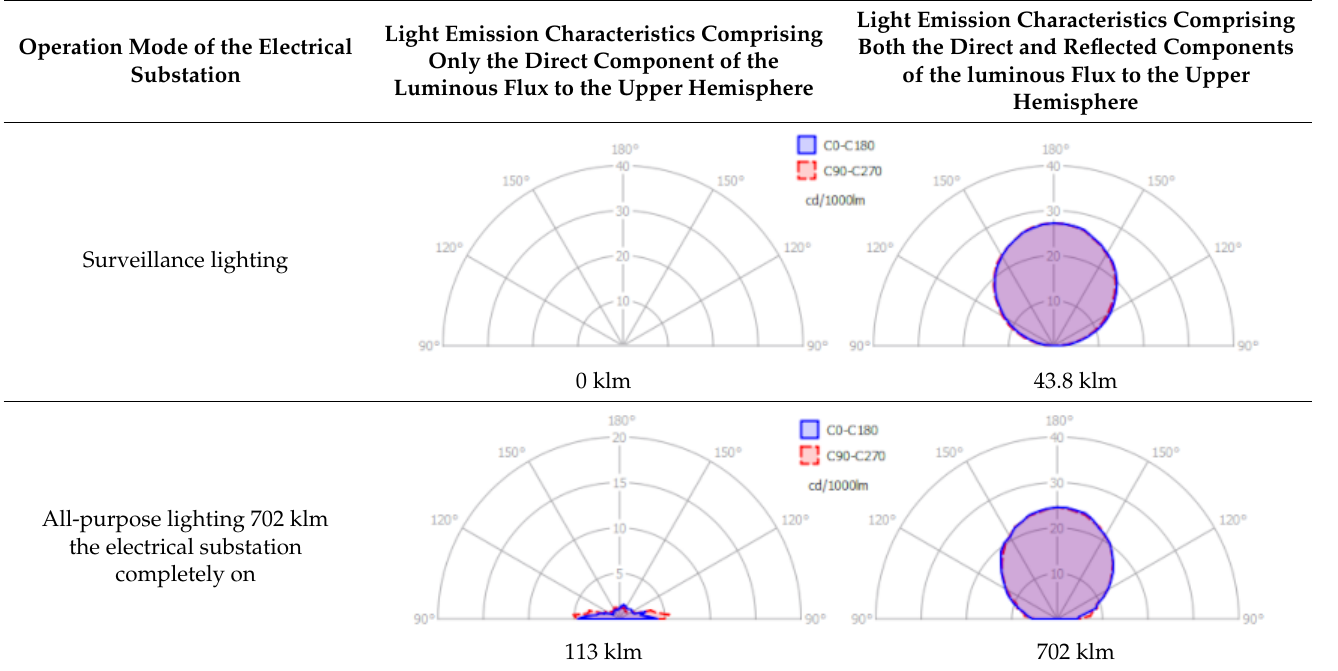
Table 8. Light emission characteristics of two operational modes of the electrical substation TR Nošovice.